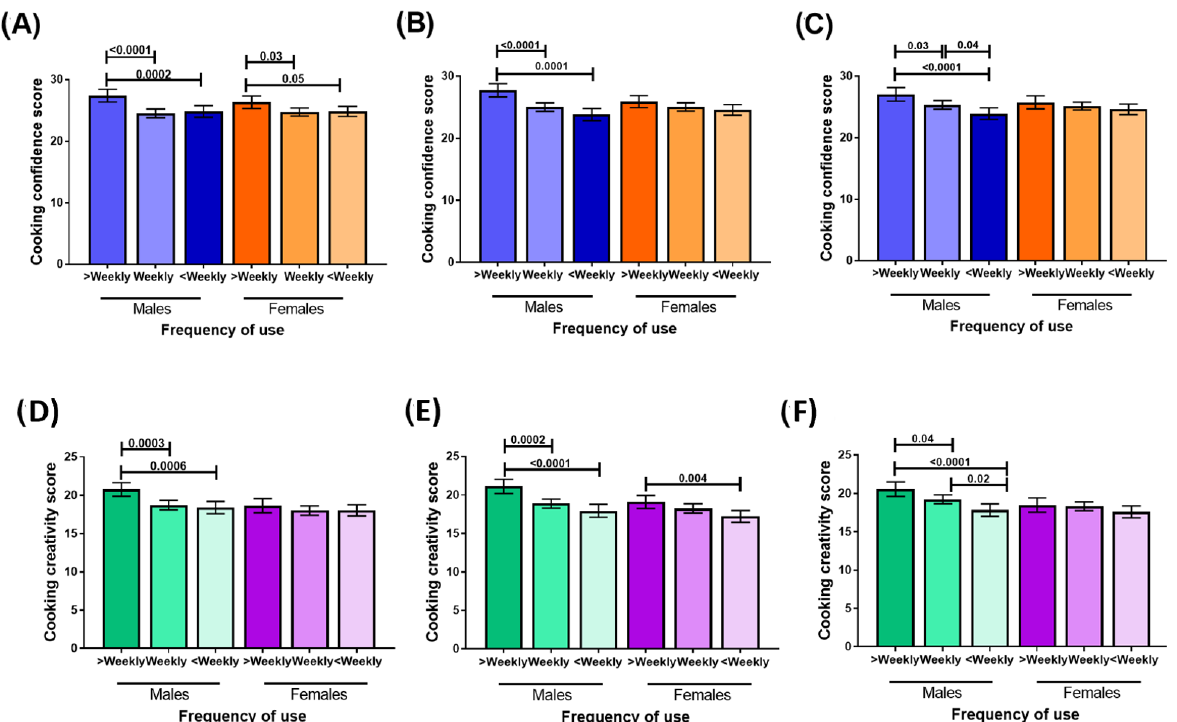
Figure 2. Cooking confidence scores by frequency of use of convenience cooking products, stratified by sex: ( A ) meal and recipe bases; ( B ) simmer sauces; ( C ) pasta sauces. Cooking creativity scores by frequency of convenience cooking product use, stratified by sex: ( D ) meal and recipe bases; ( E ) simmer sauces; ( F ) pasta sauces.